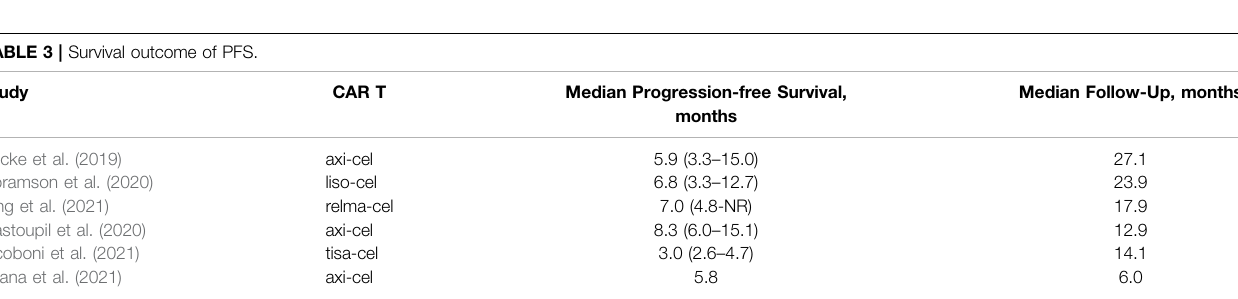
TABLE 3 | Survival outcome of PFS.